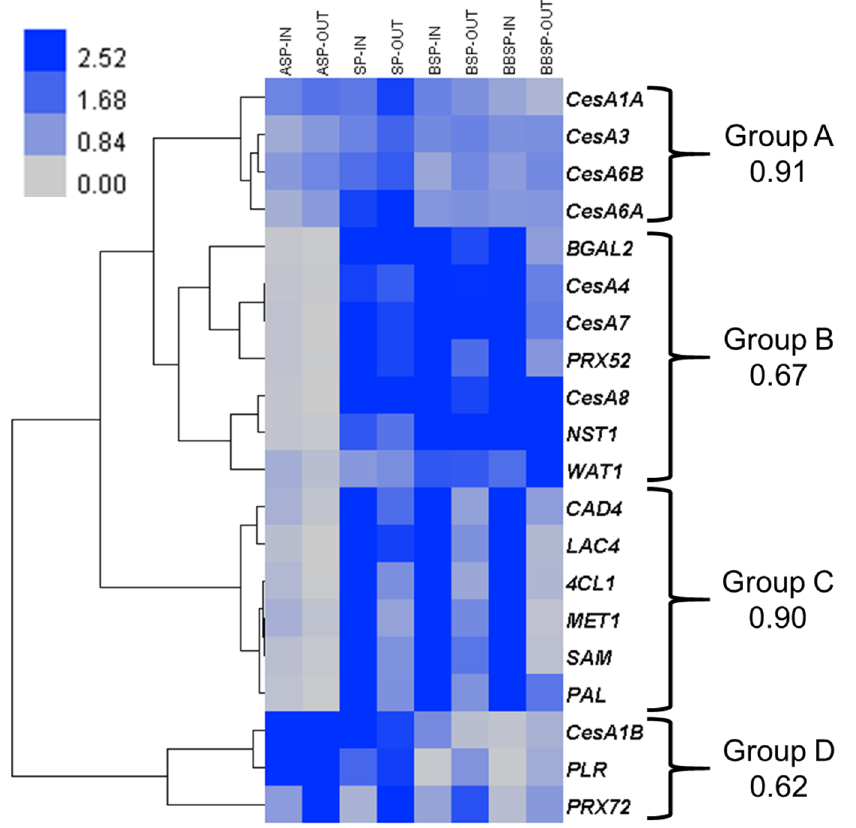
Figure 1. Gene expression analysis targeting processes related to cell wall deposition. Heat map hierarchical clustering of the expression profiles of twenty genes at four stem regions, in inner (-IN) and outer (-OUT) tissues. For each group, the Pearson correlation coefficient is provided. Abbreviations are as in the text.